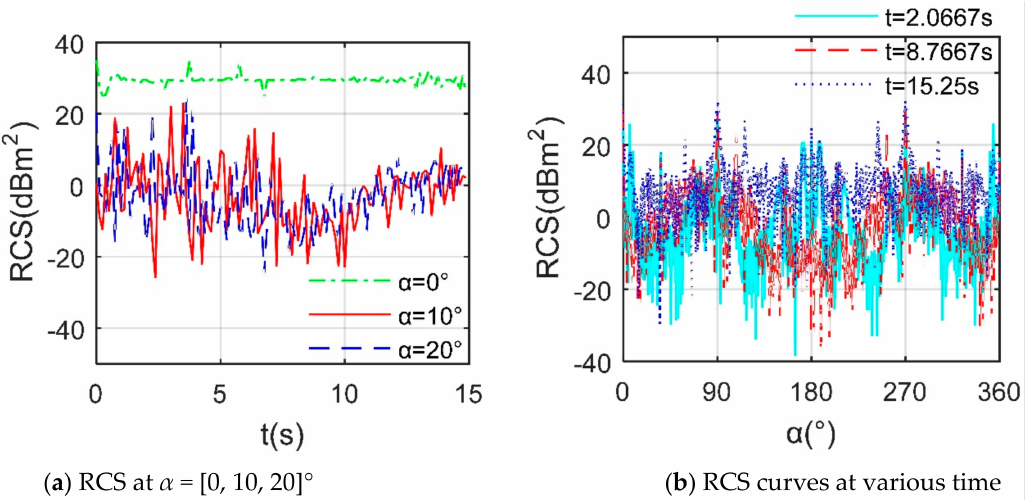
Figure 13. RCS of the tilt rotor aircraft, f rh = 10 GHz, β = 0 ◦ , n r1 = n r2 = 1500 r/min, ω c1 = ω c2 = 10.472 × 10 − 2 rad/s. ( a ) RCS curves at RCS at α = [0, 10, 20] ◦ . ( b ) RCS curves at various